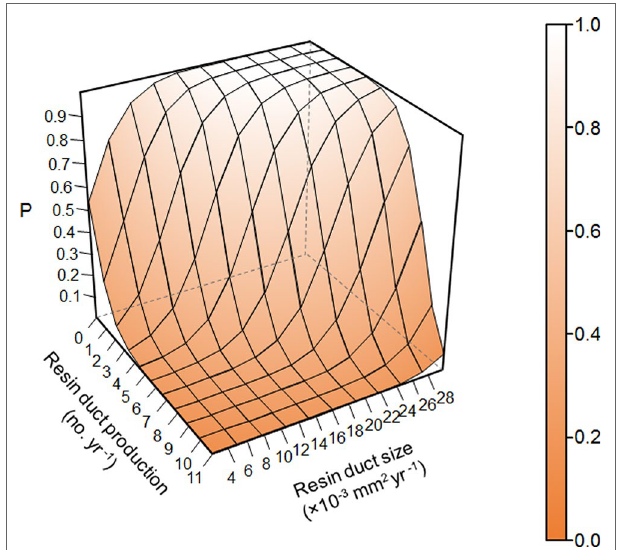
FIgURe 2 | Prediction of survival probability of Pinus contorta var. latifolia trees under Dendroctonus ponderosae attacks from the best model in Table 2 based on 10-year mean resin duct production and resin duct size of P. contorta var. latifolia trees in post-outbreak stands excluding random effects. P represents the survival probability of P. contorta var. latifolia trees under D. ponderosae